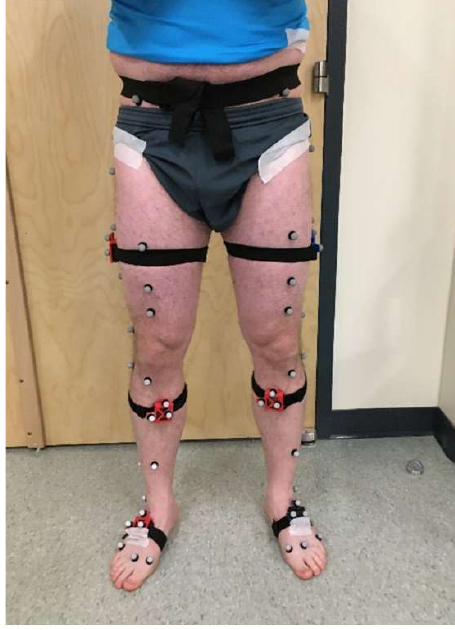
Figure 2. IMU and reflective marker placement for human subject experiments.